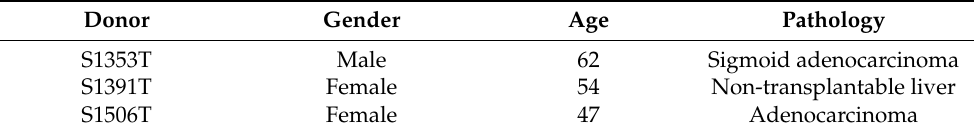
Table 1. Demographics of the donors of the cryopreserved PHH used in this study. Donor Gender Age Pathology S1353T Male 62 Sigmoid adenocarcinoma S1391T Female 54 Non-transplantable liver S1506T Female 47